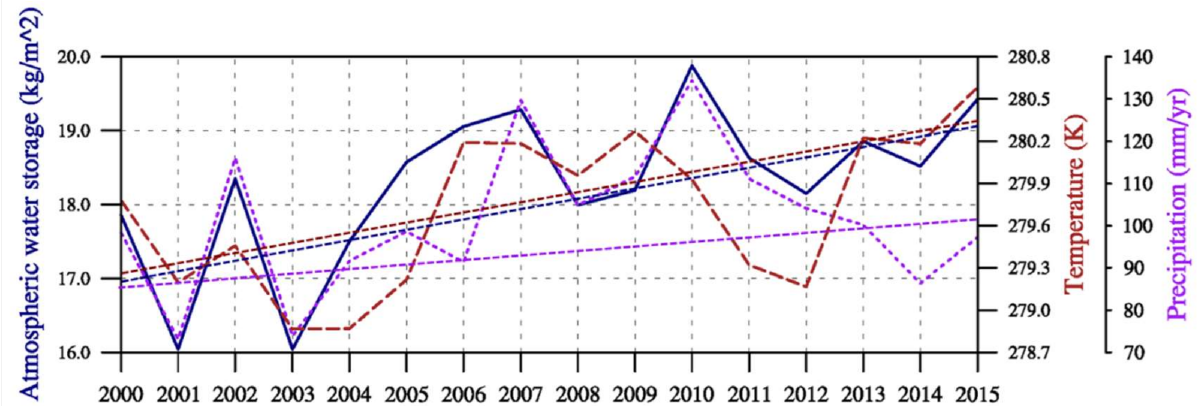
Figure 3. The change trend of the atmospheric water storage, temperature, and precipitation from 2000 to 2015. The trendline in dark blue is for water vapor, the trendline in dark red is for temperature, and the trendline in purple is for